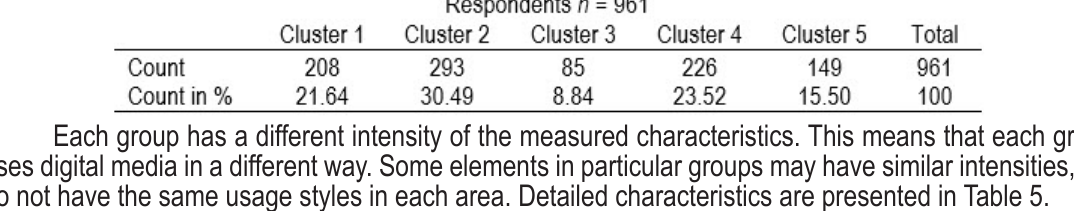
Number of respondents in each group according to the similarities of the questionnaire item evaluations